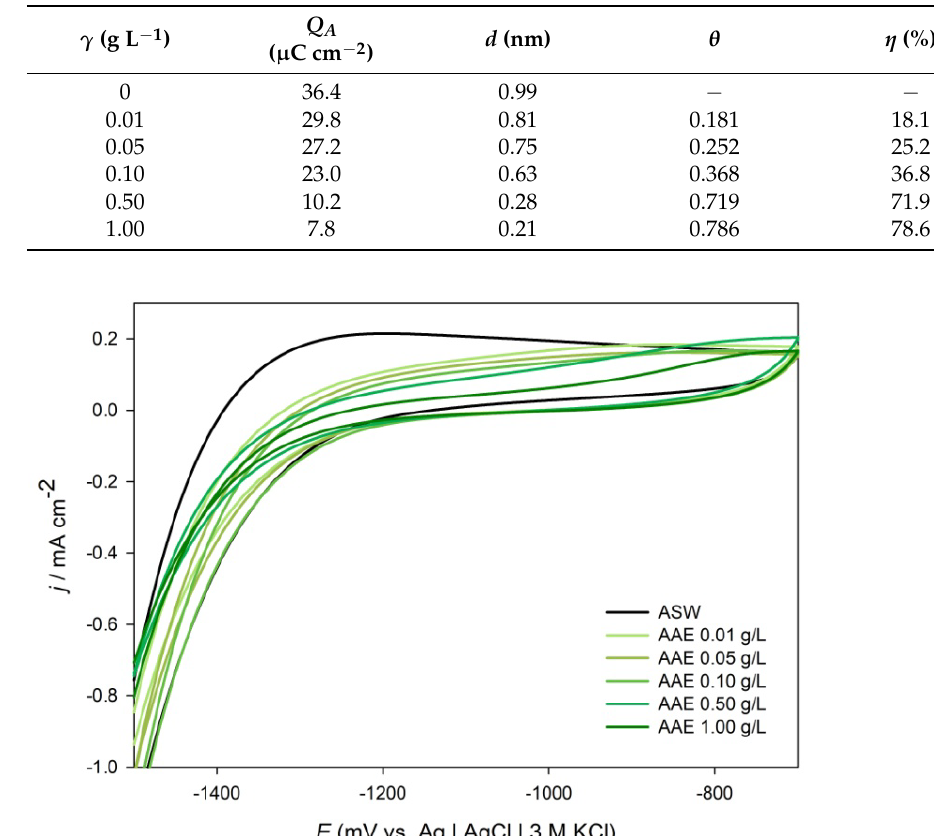
Figure 2. Cyclic voltammograms for the aluminium alloy 5083 recorded in ASW without and with the addition of different concentrations of Artemisia annua L. extract (AAE, shown in figure); ν = 30 mV s − 1 .